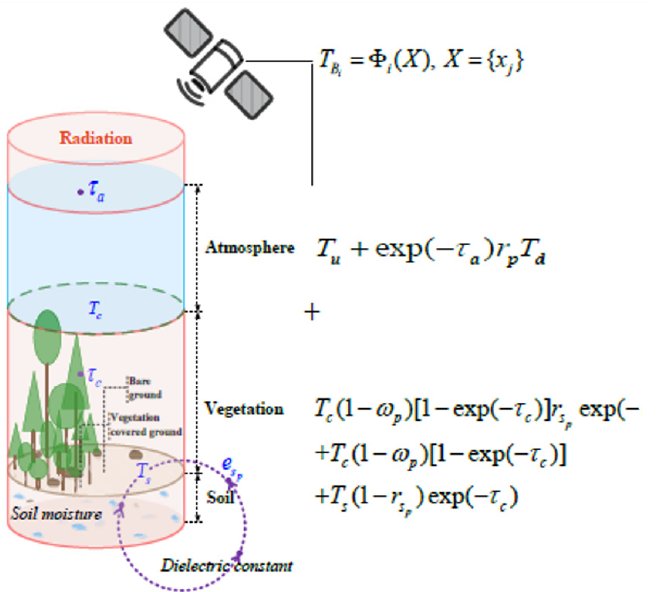
Figure 2. A simplified diagram of thermal RT modeling to relate LST and SM to brightness tempera- ture